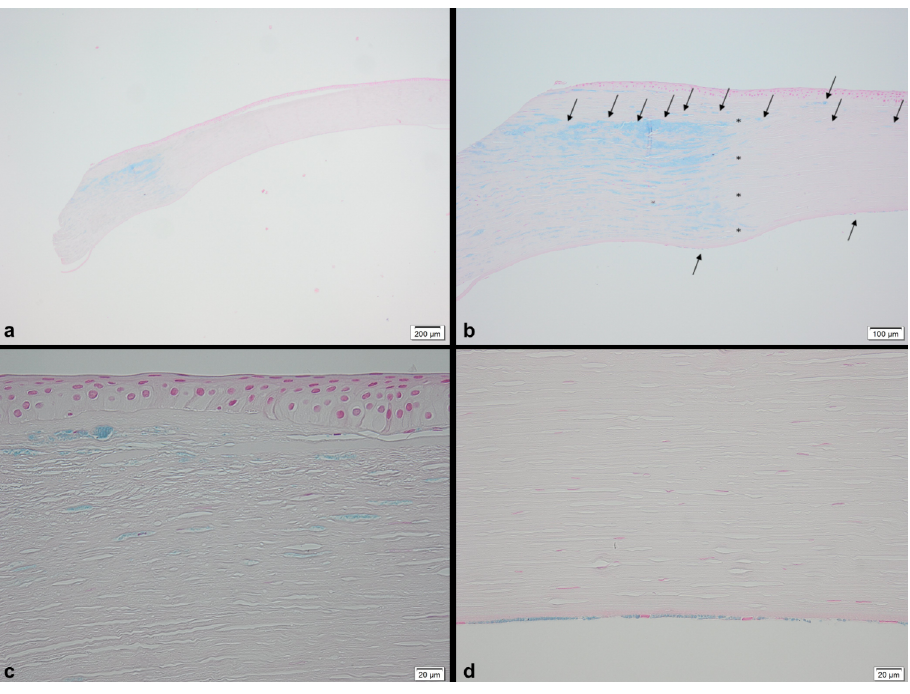
Figure 2: Histological analysis